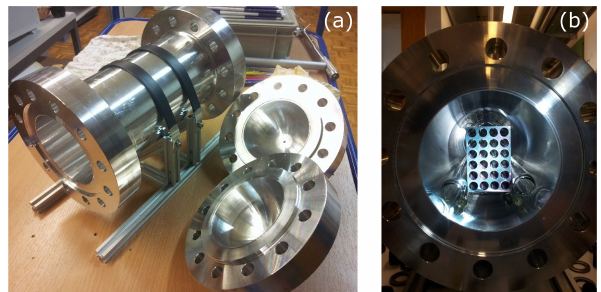
Figure 1. (a) Custom-made cylinder of three pieces. (b) Material loading into the cylinder. The metal blocks are placed on the glass ladder, and two rod-shaped glass pieces support the material from the